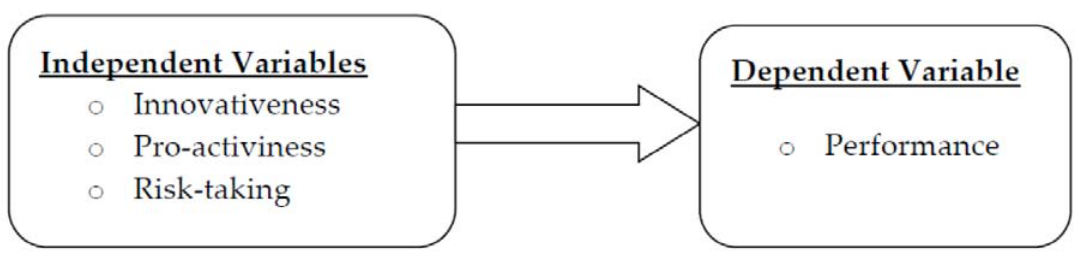
Figure 1. Conceptual framework of this study. Source: own compilation from related studies that were reviewed.